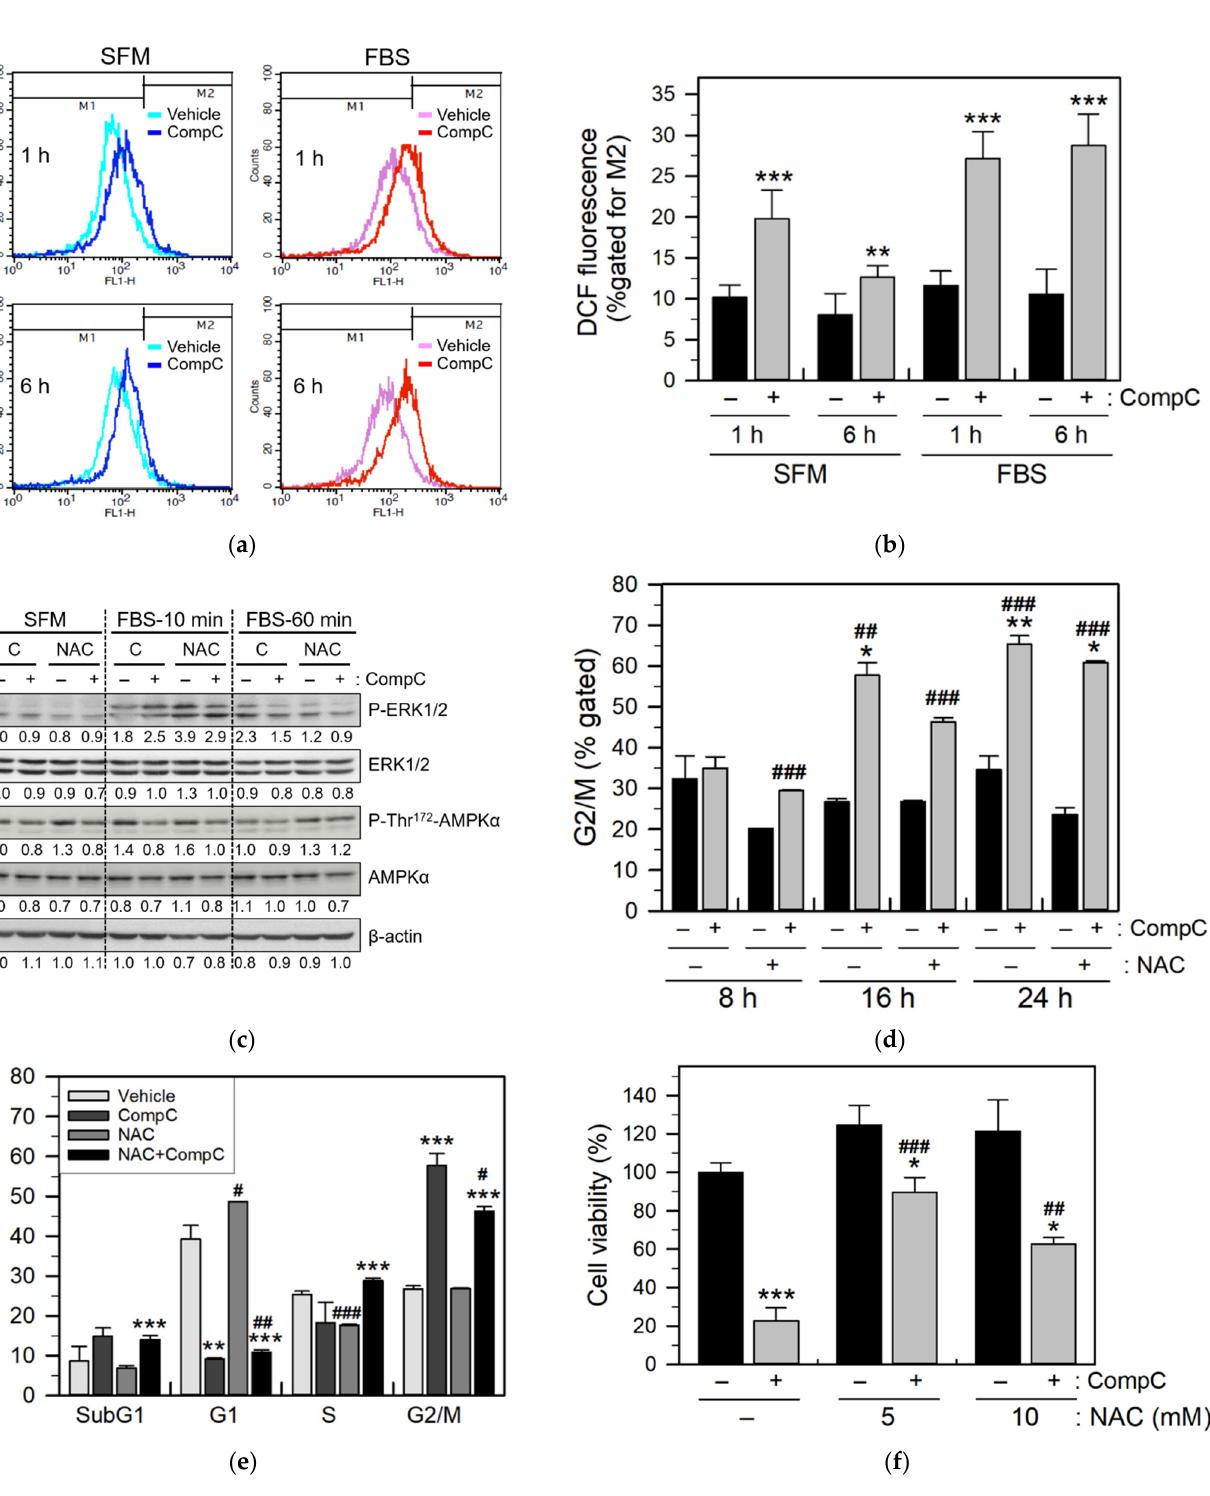
Figure 4. CompC generated reactive oxygen species (ROS), which induced G2/M cell cycle arrest and cell viability reduction. ( a , b ) Renca cells were treated with the vehicle ( − ) or 10 μ M CompC in the SFM or FBS medium for 1 and 6 h, and the levels of intracellular ROS were evaluated by flow cytometry after incubating cells with DCF-DA for 30 min ( a ). The percentage of cells gated in the M2, is plotted as the mean ± SD ( b ). ( c – e ) Renca cells were pretreated with PBS (C) or 5 mM N-acetyl cysteine (NAC), an ROS scavenger, for 1 h before vehicle or CompC treatment. Cells were stimu- lated with 10% FBS for the indicated times and cell lysates were analyzed by western blot to deter- mine ERK1/2 activation and the status of AMP-activated protein kinase (AMPK) activity using an- tibodies against P-ERK1/2, ERK1/2, P-Thr 172 -AMPK α , AMPK α , and β -actin as an internal control ( c ). The band densities were normalized against β -actin and the fold changes compared to that of the control (SFM/C/ − CompC) are written under each band. Cell cycle analysis was also performed by flow cytometry after PI staining of cells pre-treated with vehicle, NAC and/or CompC, and stimu- lated with 10% FBS ( d , e ). The percentage of cells gated in the G2/M phase in the indicated times ( d ) and the percentage of cells gated in the subG1, G1, S, and G2/M phase at 16 h ( e ) are plotted as the mean ± SD (n = 8). ( f ) The cell viability of NAC-treated cells was measured by MTT assay and the percentage of cell viability is plotted as the means ± SD with n = 8. * p < 0.05, ** p < 0.01 and *** p < 0.001, compared with vehicle-treated control cells ( − CompC). # p < 0.05, ## p < 0.01, ### p < 0.001, com- pared with vehicle- or CompC-treated cells in the absence of NAC ( − NAC). 2.3. CompC Inhibits the Phosphorylation of Histone H3 via the Inhibitory Tyrosine Phosphorylation of Cdk1 by Wee1 To clarify how CompC induces G2/M cell cycle arrest in Renca cells, its long-term effect on the expression and phosphorylation status of cell cycle-related proteins was ex- amined using western blot analysis. Subconfluent Renca cells were serum starved over- night, pre-treated with the vehicle or 10 μ M CompC for 1 h, and then stimulated with 10% FBS for 8–24 h. Cdk1, also known as Cdc2, functions as a serine/threonine kinase that plays an im- portant role in the entry of cells into mitosis [29]. Cdk1 complexes with cyclin B1 (or cyclin A) and phosphorylates a variety of target substrates, including histone H3, another mitotic indicator. Cdk1 phosphorylation at Thr 161 by the Cdk-activating kinase (CAK) induces ac- tivation of Cdk1, whereas phosphorylation at Tyr 15 induces its inhibition [29,30]. Interest- ingly, we observed that CompC treatment increased the level of phosphorylated Cdk1 on Tyr 15 (P-Tyr 15 - Cdk1) at 16–24 h (Figure 5a). Furthermore, the level of phosphorylated his- tone H3 on Ser 10 (P-Ser 10 -H3) was significantly increased by serum treatment, and this increase was abrogated by CompC treatment at 8–24 h. The increase in the inhibitory ty- rosine phosphorylation of Cdk1 in CompC-treated cells might cause a reduction in P- Ser 10 -H3, resulting in the blockage of chromosomal condensation and segregation during mitosis.